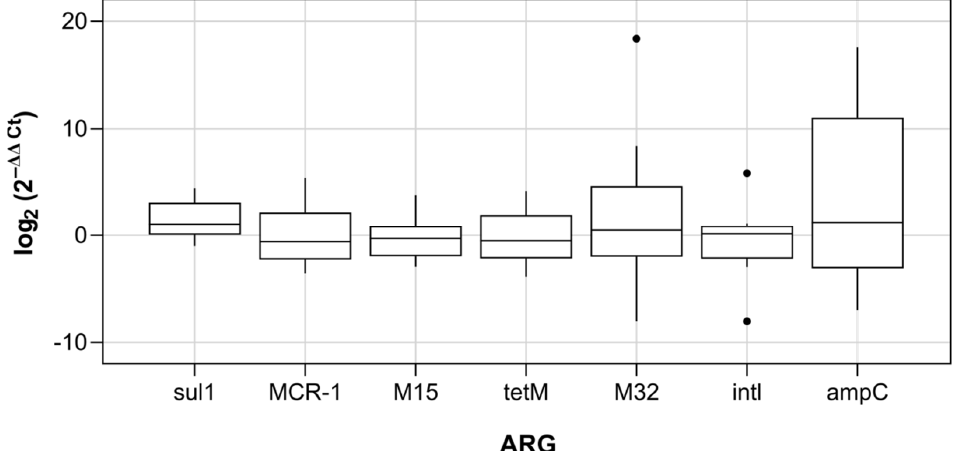
Figure 11. Normalized expression levels of ARGs in the sediment samples taken upstream and downstream of the WWTP. ● indicate data points located outside whiskers of the Tukey's boxplot (outliers)